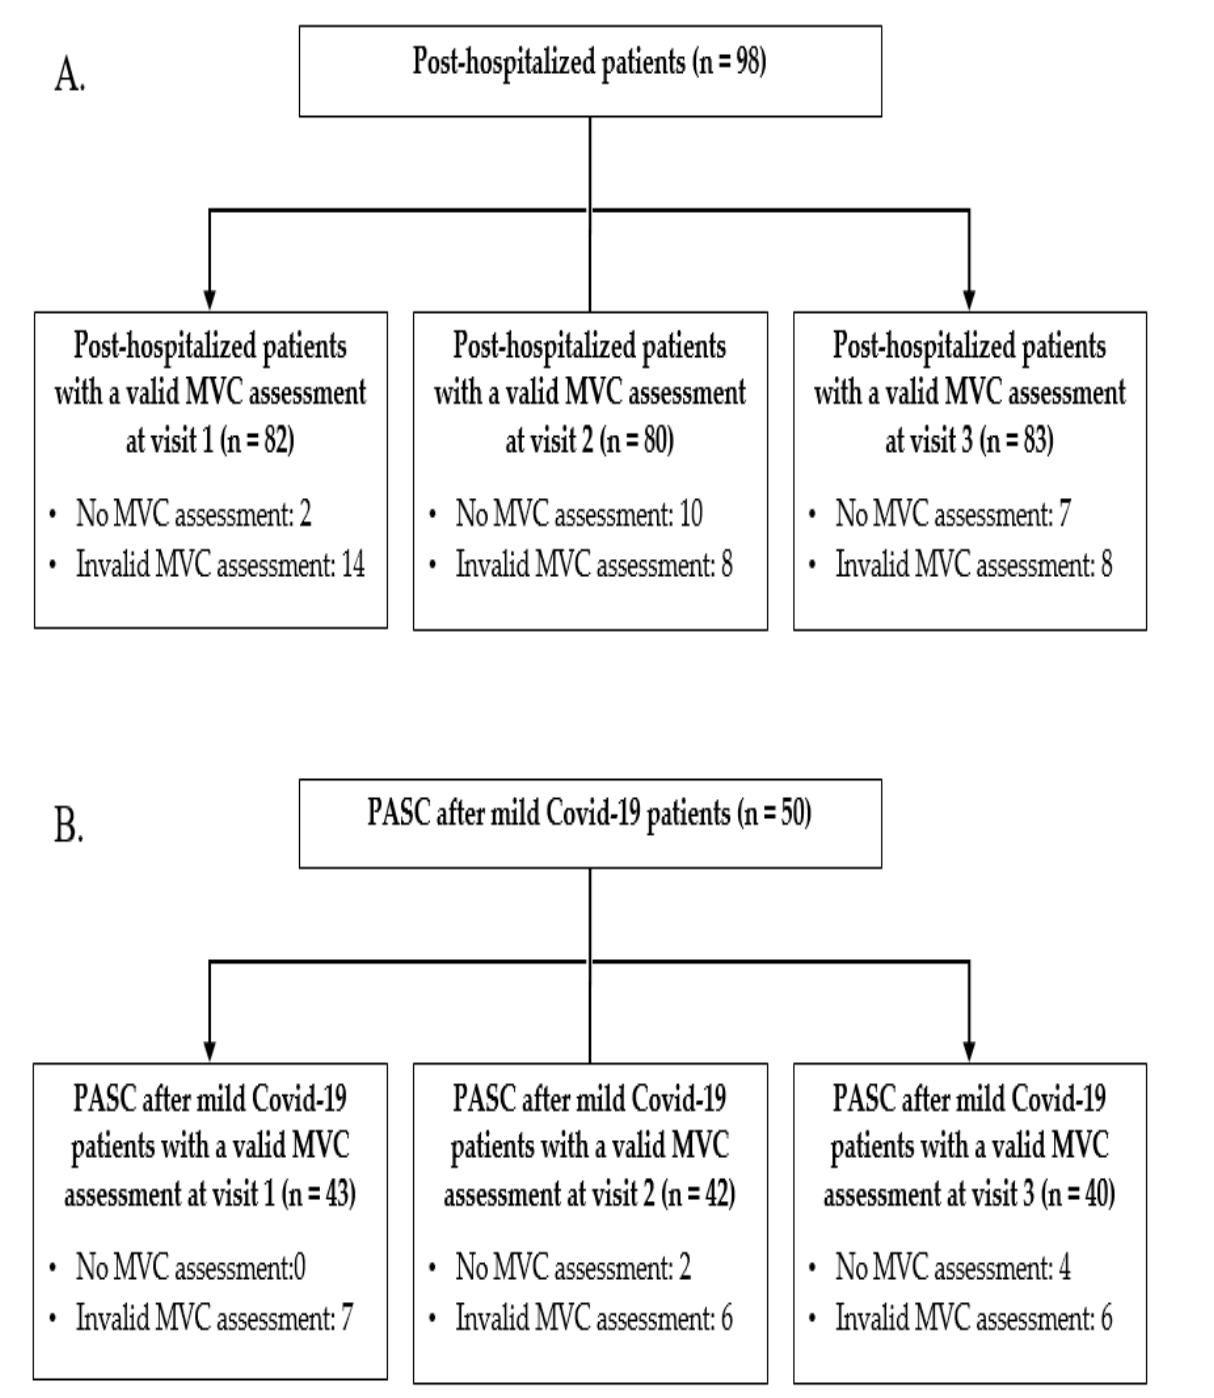
Figure 1. Flowchart of post-hospitalized ( A ) and PASC after mild COVID-19 ( B ) patient inclusion. Abbreviations: MVC: maximal voluntary contraction; PASC: post-acute sequelae of COVID-19.